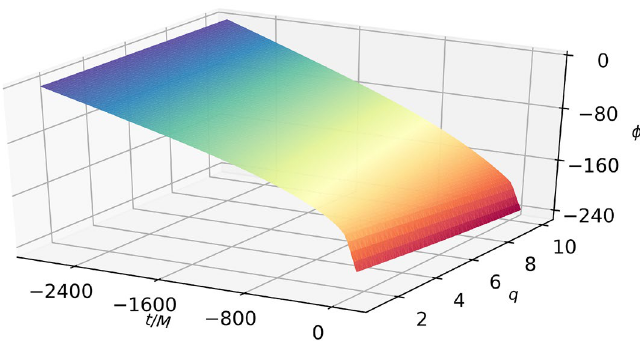
Figure 4. Symbolic phase as a function of the mass ratio q = m 1 / m 2 and